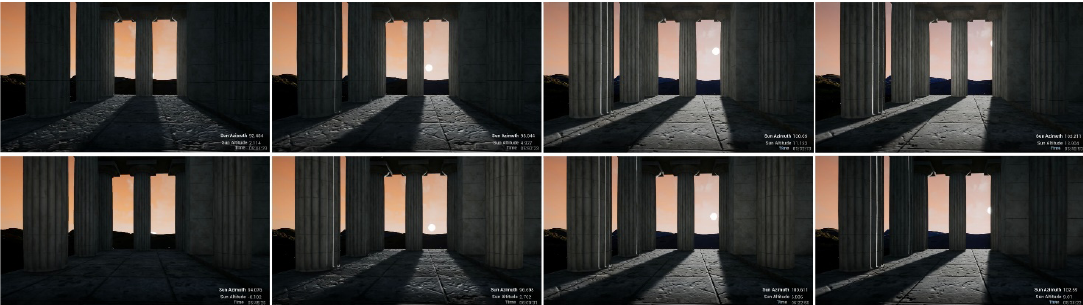
Figure 6. Virtual reality simulation model of the temple’s interior showing the progression of the sunbeam a week before the equinoxes when the sun was aligned to the east entrance between 500–100 BCE.